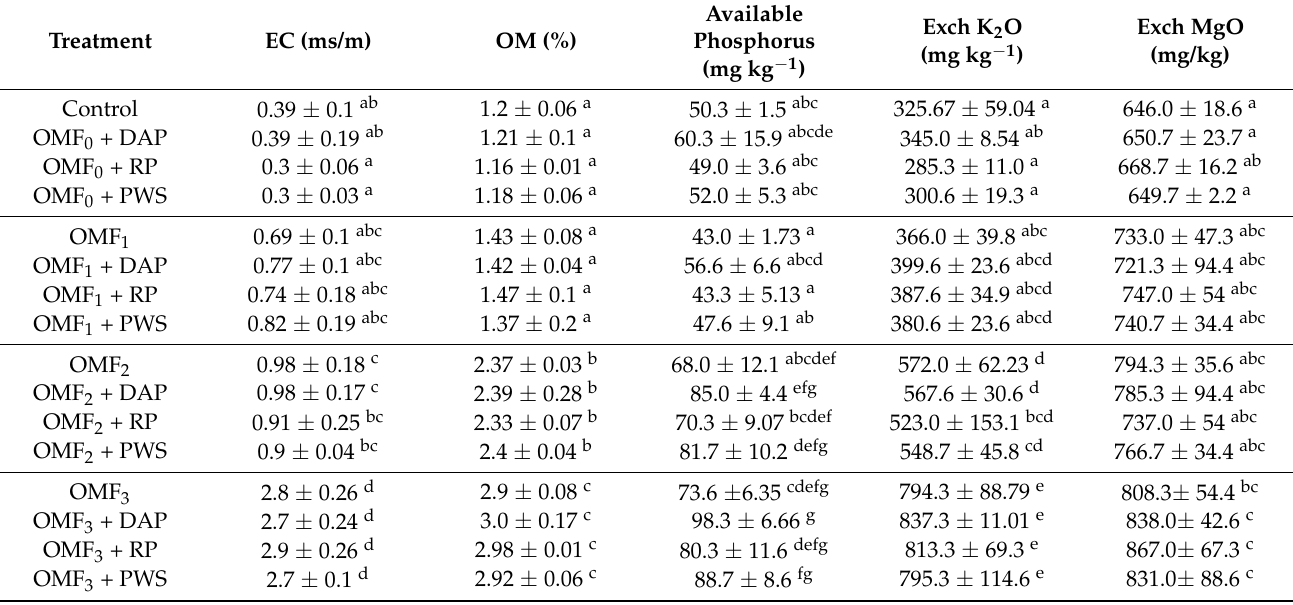
Table 2. Physicochemical properties of the plantless soil after 2 weeks of OMF applications.